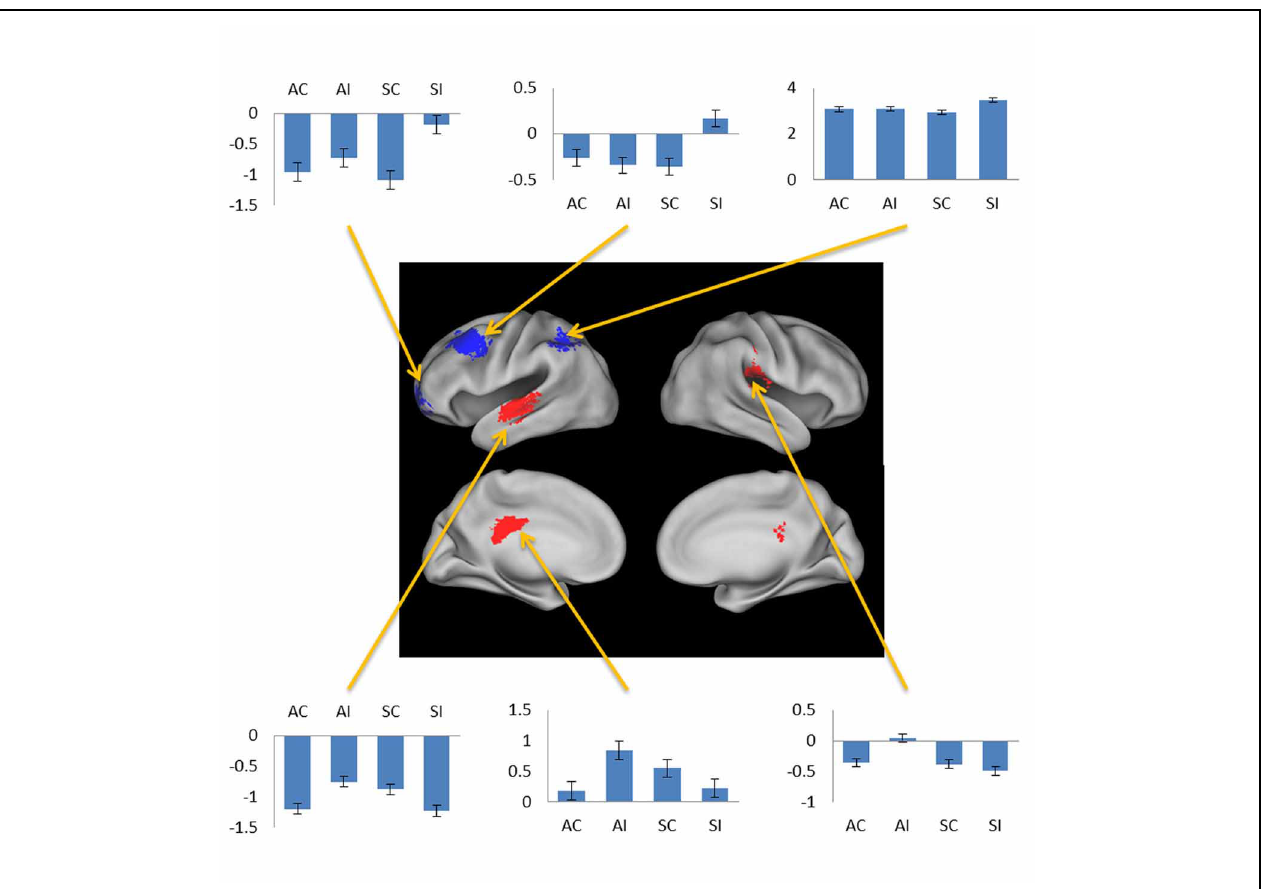
FIGURE 5 | Negative subsequent memory effects selective for associative (red) and source (blue). Bar plots show mean parameter estimates for the four conditions of interest for peak voxels (arrows, clockwise) in left orbitofrontal gyrus, left middle frontal gyrus, left